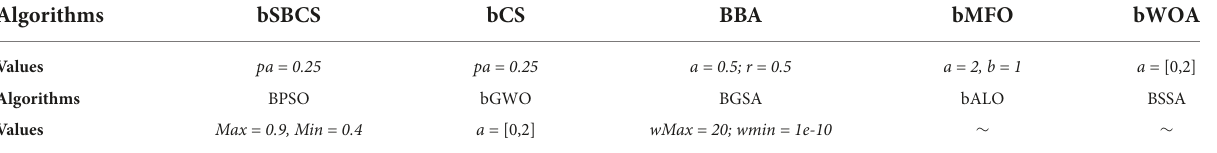
TABLE 9 Setting the parameters for the optimization